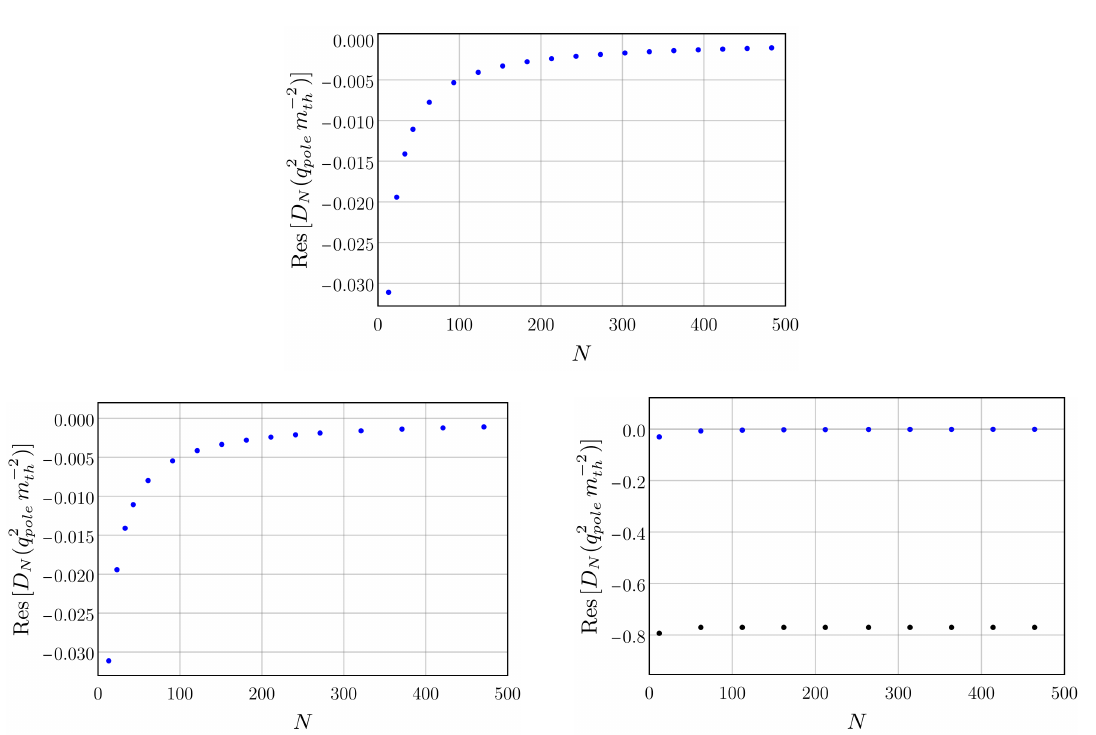
Figure 6 . Residues of the truncated propagator (3.13) at its poles as a function of the truncation order N , for the case of QED (top panel), Lee Wick QED (bottom left panel) and Lee-Wick QED with non-standard coupling (bottom right panel). As in figure 3, blue dots refer to fictitious poles while the black dots describe the true ghost. The residues associated with the fake ghosts tend to zero as N → ∞ . The residue of the real ghost is always negative